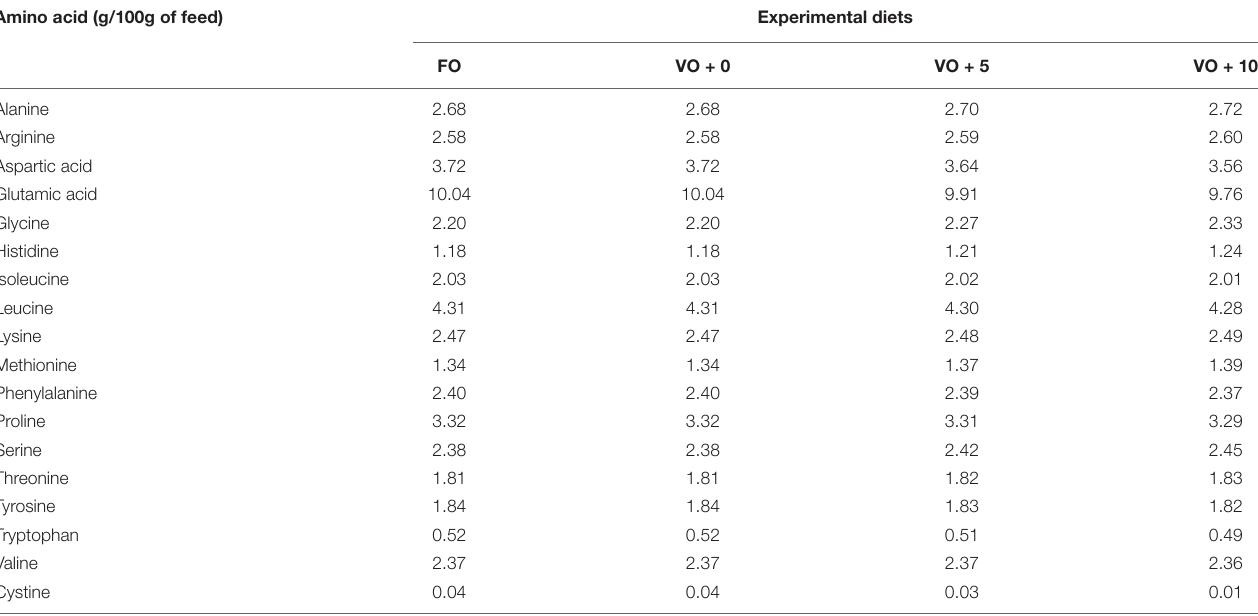
TABLE 2 | Amino acids composition of the four different experimental diets. Amino acid (g/100g of